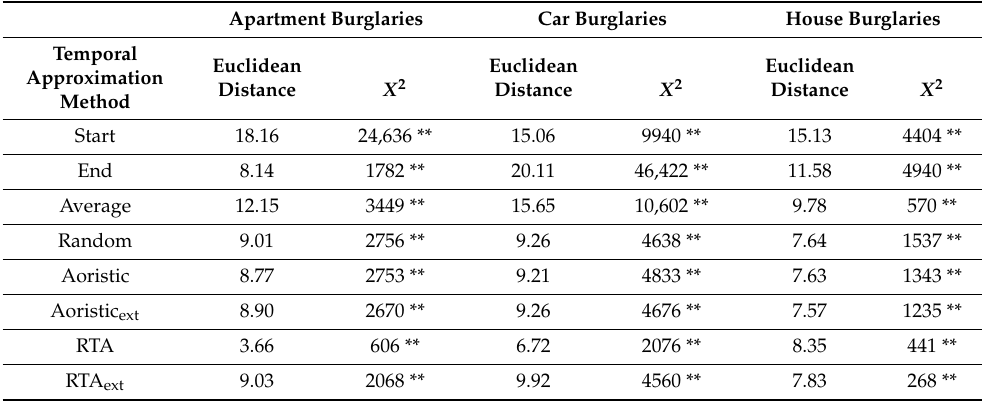
Table 2. Evaluating the distance and the correlation between the observed and estimated occurrence times of eight di ff erent temporal approximation methods for three di ff erent crime